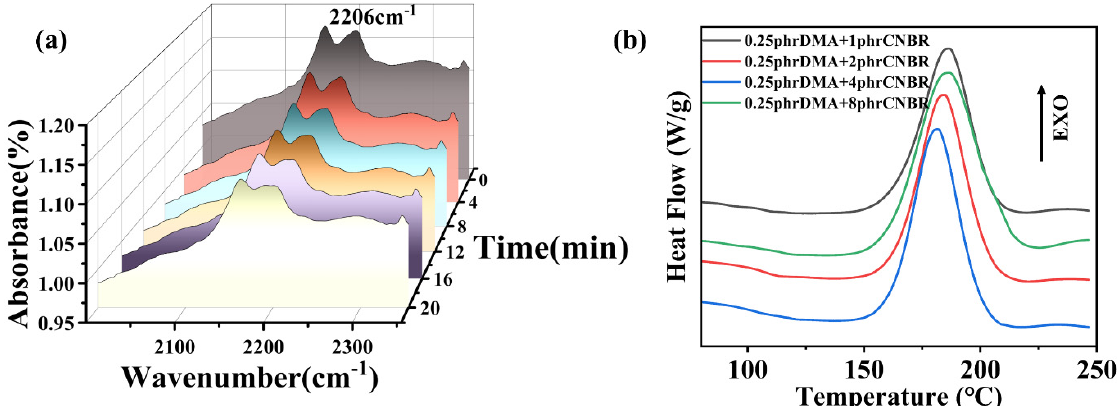
Figure 6. ( a ) The characteristic absorption peak of the nitrile group in CNBR changed at 160 °C. ( b ) DSC curves of 0.25phr DMA and different-ratio CNBR-modified epoxy coatings.